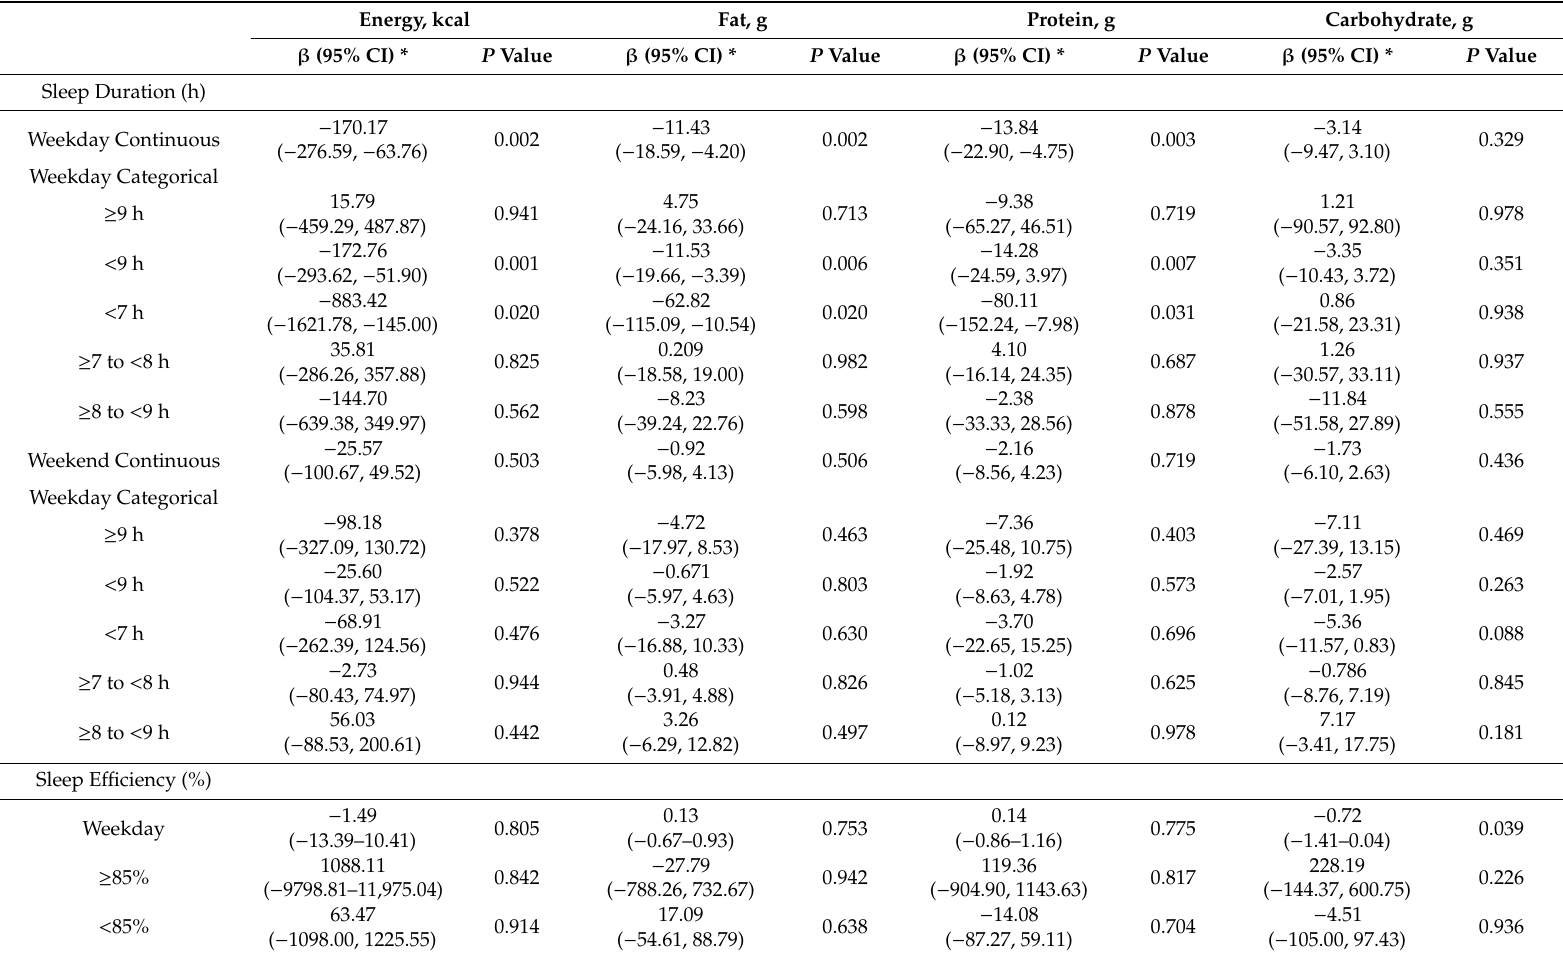
Table 3. Relationship between actigraphic sleep parameters and dietary